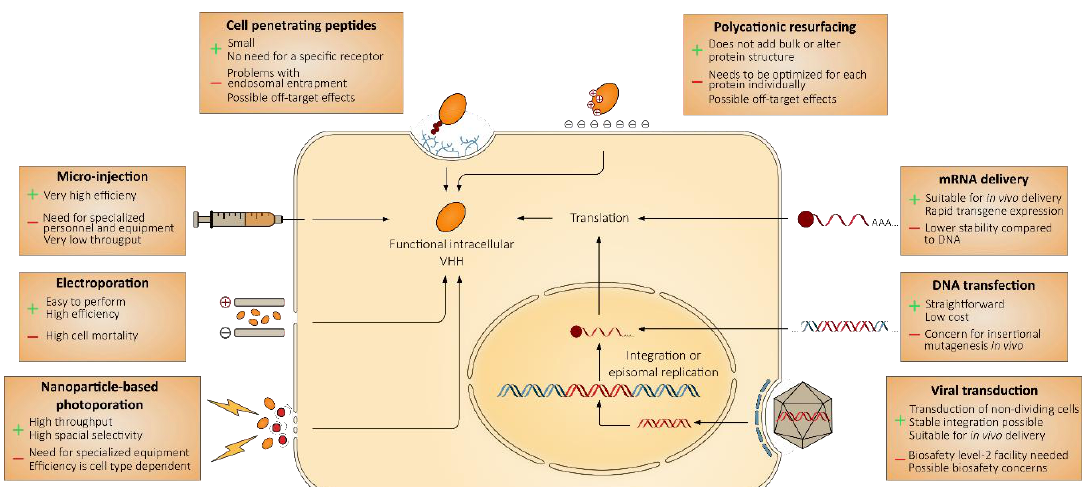
Figure 2. Schematic diagram of methods that are available to deliver VHHs into the cytosol of the cell. Methods such as micro-injection, electroporation and photoporation ( left ) require (transient) physical disruption of the cell membrane, while coupling to cell penetrating peptides and polycationic resurfacing ( top ) are based on electrostatic interactions with the cell surface. Expression based methods include mRNA, DNA or viral vector-based delivery processes ( right ).